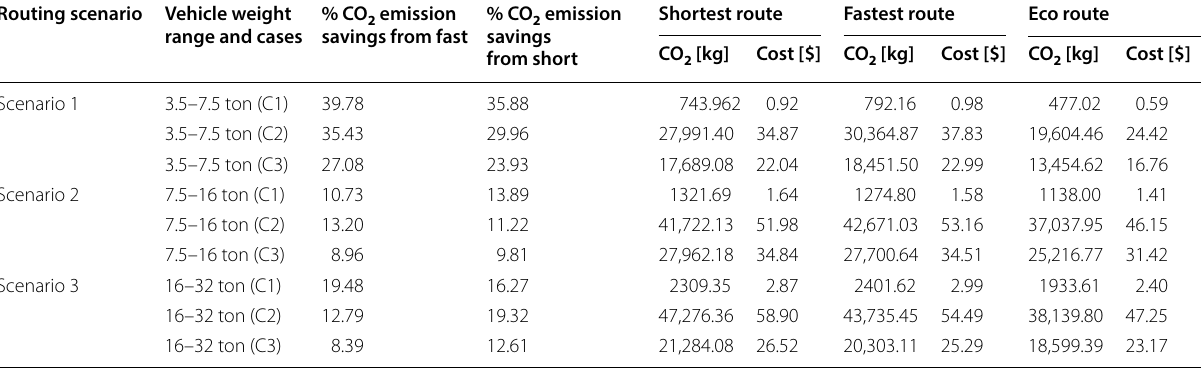
Table 6 Eco routes CO saving potential for each scenario cases (1–3) from its alternative routes parameter results 2